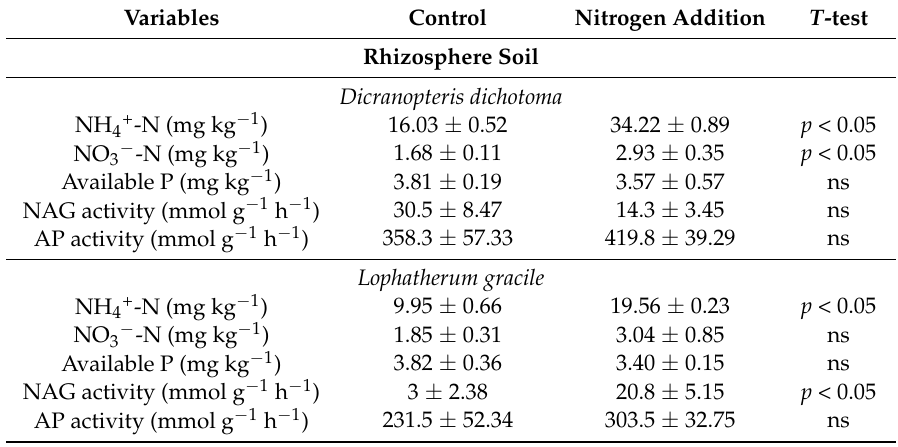
Table 2. Available nutrients and enzyme activities in rhizosphere and bulk soils of the three understory plant species in the Chinese fir plantation treated by nitrogen addition or in the control.